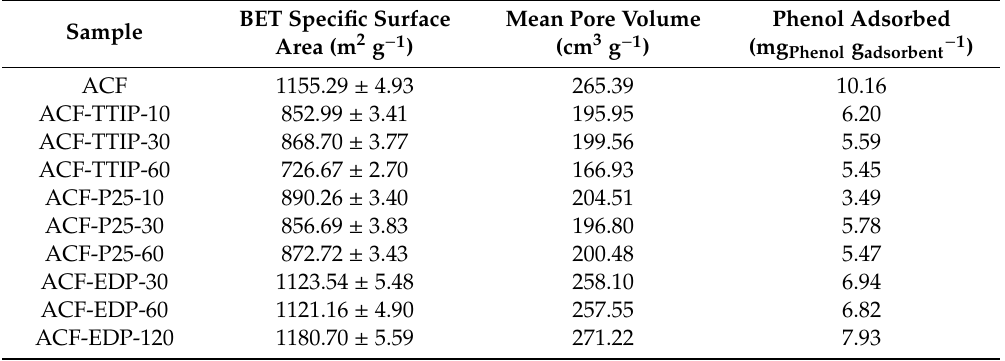
Table 3. Results of Brunauer − Emmett − Teller (BET) analysis and phenol adsorption testing with original ACF and ACF / TiO 2 composites (Table